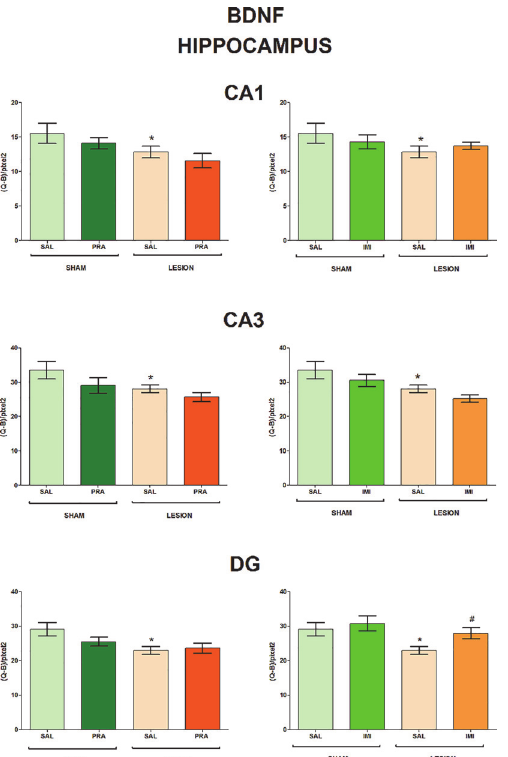
Fig 2. The influence of 6-OHDA, pramipexole and imipramine on BDNF mRNA in the hippocampus. The results are expressed as the mean ± S.E.M. LESION — lesioned rats, IMI — imipramine, PRA — pramipexole, Q-B/pixel2 — the mean optical density-background per area units, SAL — saline, SHAM — sham- operated rats, n = 7 – 10, differences between SHAM-SAL vs. other groups are indicated by * p (cid:1) 0.05, and differences between LESION-SAL vs. other groups by #p (cid:1) 0.05). For further explanations see Fig. 1.